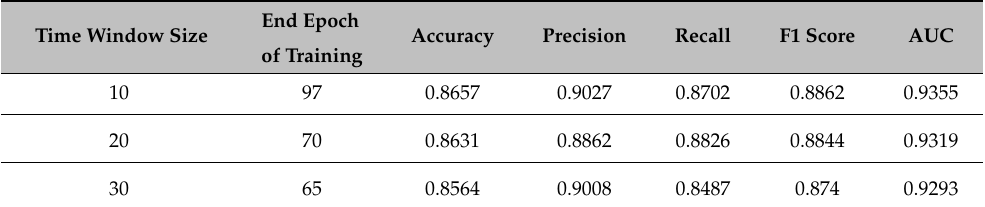
Table 5. Evaluation results on the test set. End epoch of training means the last epoch at training stopped by the early stop